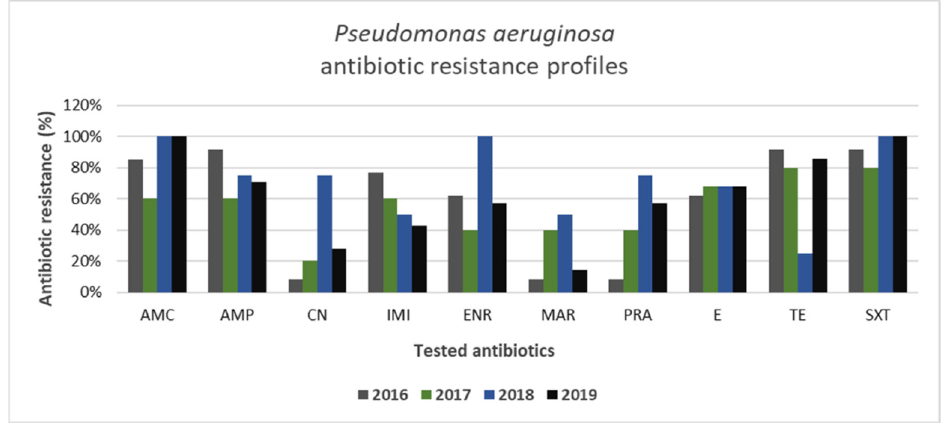
Figure 8. Antimicrobial resistance profiles of canine Pseudomonas aeruginosa strains to commonly used antibiotics.